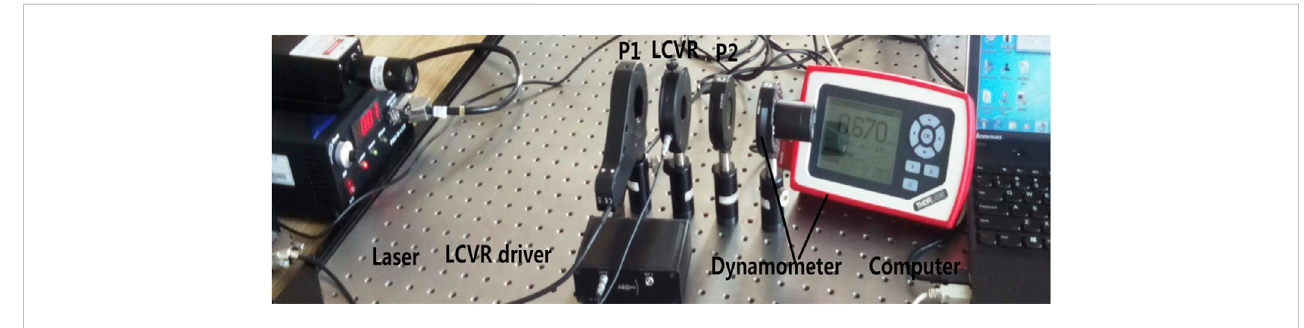
FIGURE 5 The site of phase delay characteristics tested by the light intensity